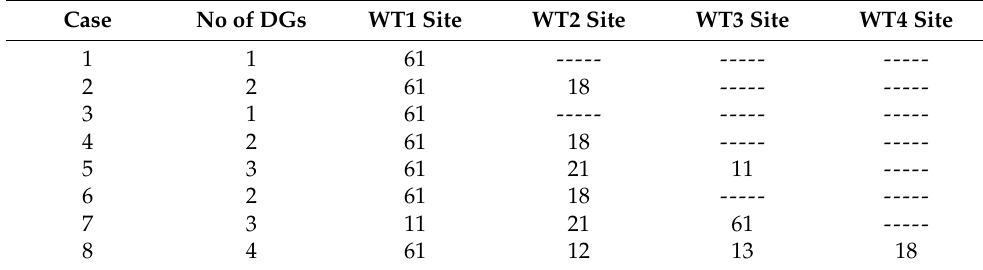
Table 7. Optimal wind turbine (WT) DG locations for the IEEE 69-bus test system using